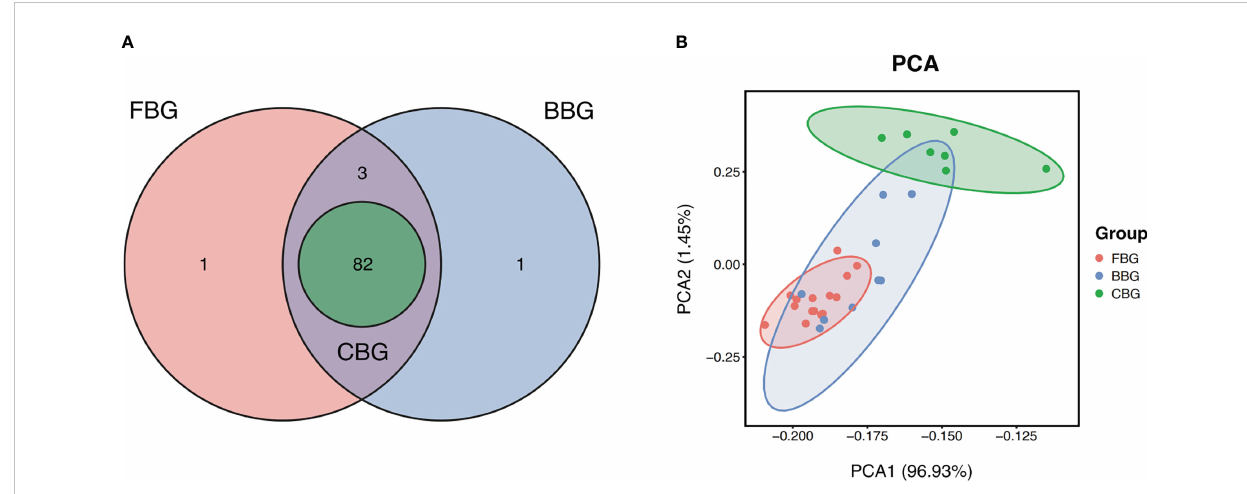
FIGURE 2 FBG, BBG, and CBG have unique protein expression pro fi les. (A) Venn Diagram shows the number of proteins with expression higher than the limit of detection shared and unique in FBG, BBG, and CBG. (B) PCA plot projects all 31 patients to two dimensions showing 3 groups differentiated by color. Each point represents a single patient, with patients of similar protein expression pro fi les positioned next to each other. Explained Variance: PCA1 = 96.93%, PCA2 =